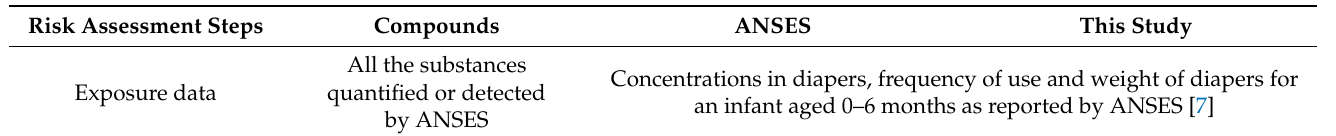
Table 1. Comparison of the risk assessment methodology used by ANSES with that recommended in this